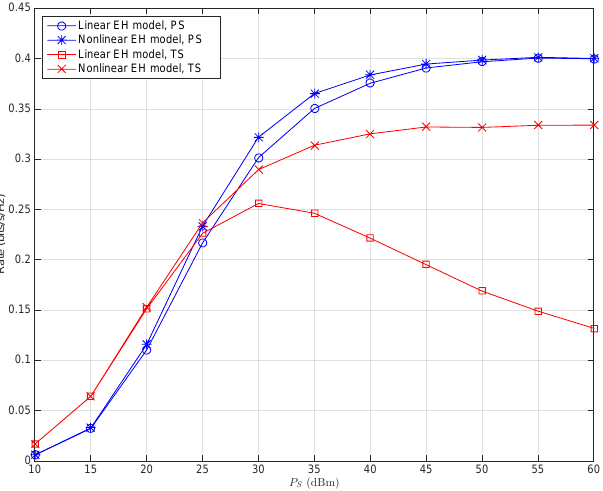
Figure 3. Maximum achievable rate versus the transmit power P s (dBm) for the SWIPT multi-relay cooperative system with PS and TS schemes when N 0 = 10 dBm, K R = 0 dB, β = 2, d sc = 2 m, d cd = 4 m.